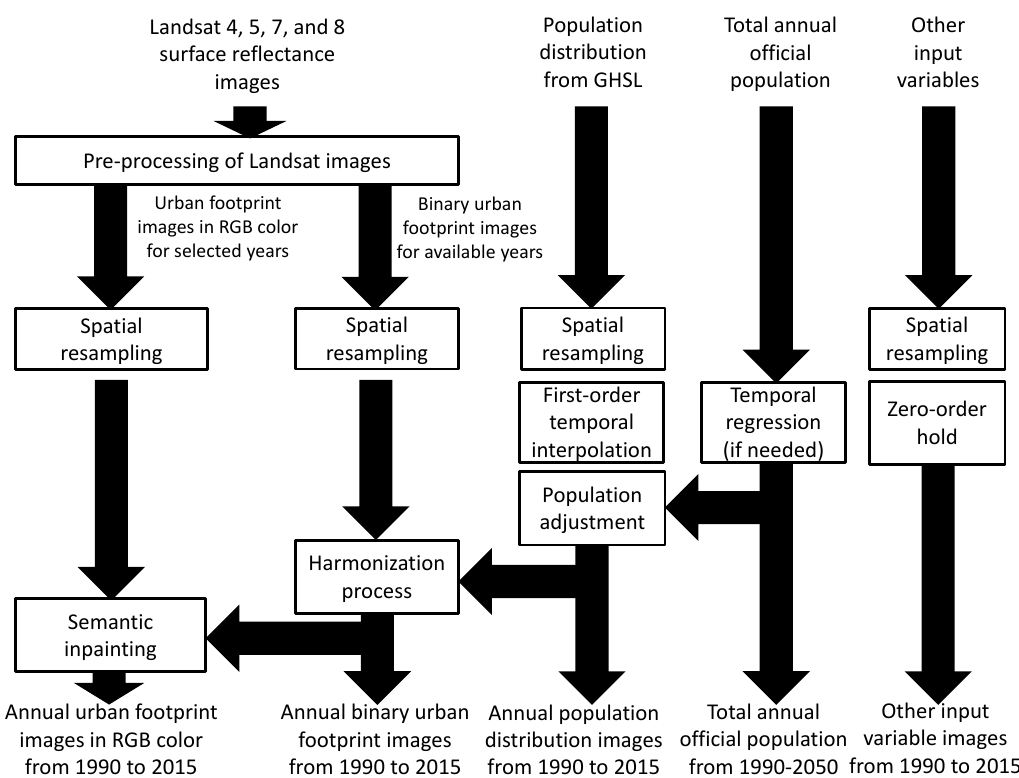
Figure 2. A high-level overview of the data pre-processing applied to all the input variables of the urban growth